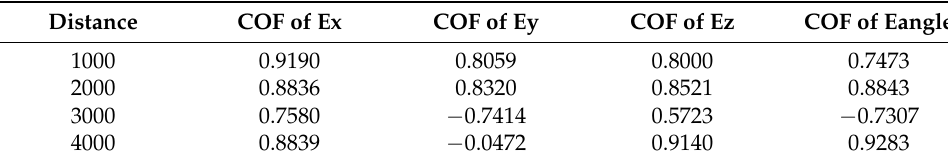
Figure 9. Measurement error curve of the algorithm for different distances and angles of the pallet. ( a ) Curve chart of measurement error in X − axis direction versus pallet angle. ( b ) Curve chart of measurement error in Y − axis direction versus pallet angle. ( c ) Curve chart of measurement error in Z − axis direction versus pallet angle. ( d ) Curve chart of angel measurement error versus pallet angle. Table 1. Correlation between parameter error and pallet angle.